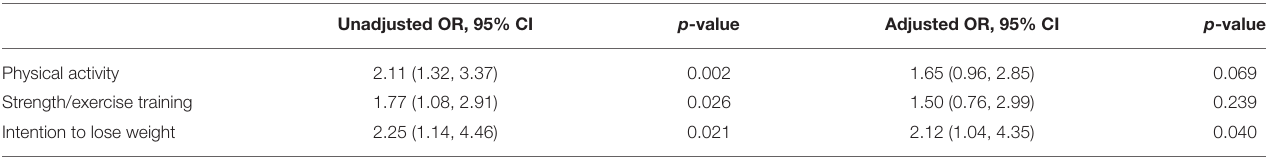
TABLE 2 | Adjusted and unadjusted odds of association between electronic wearable devices (EWDs) use and physical activity parameters among individuals with depression and